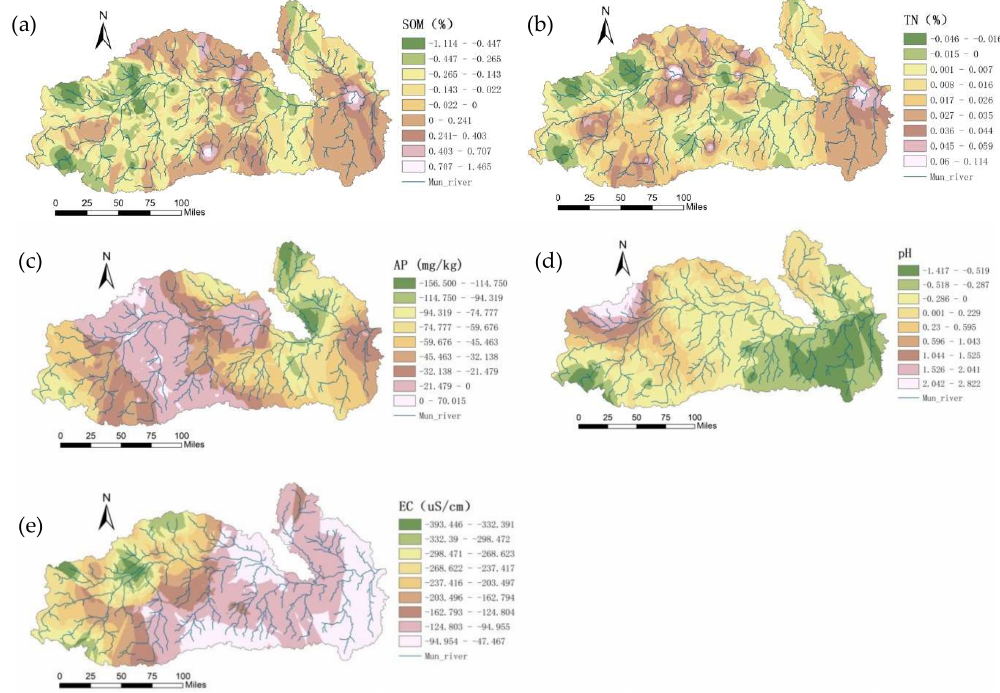
Figure 8. Spatial patterns of SOM ( a ), TN ( b ), AP ( c ), pH ( d ), and EC ( e ) in the rainy season.